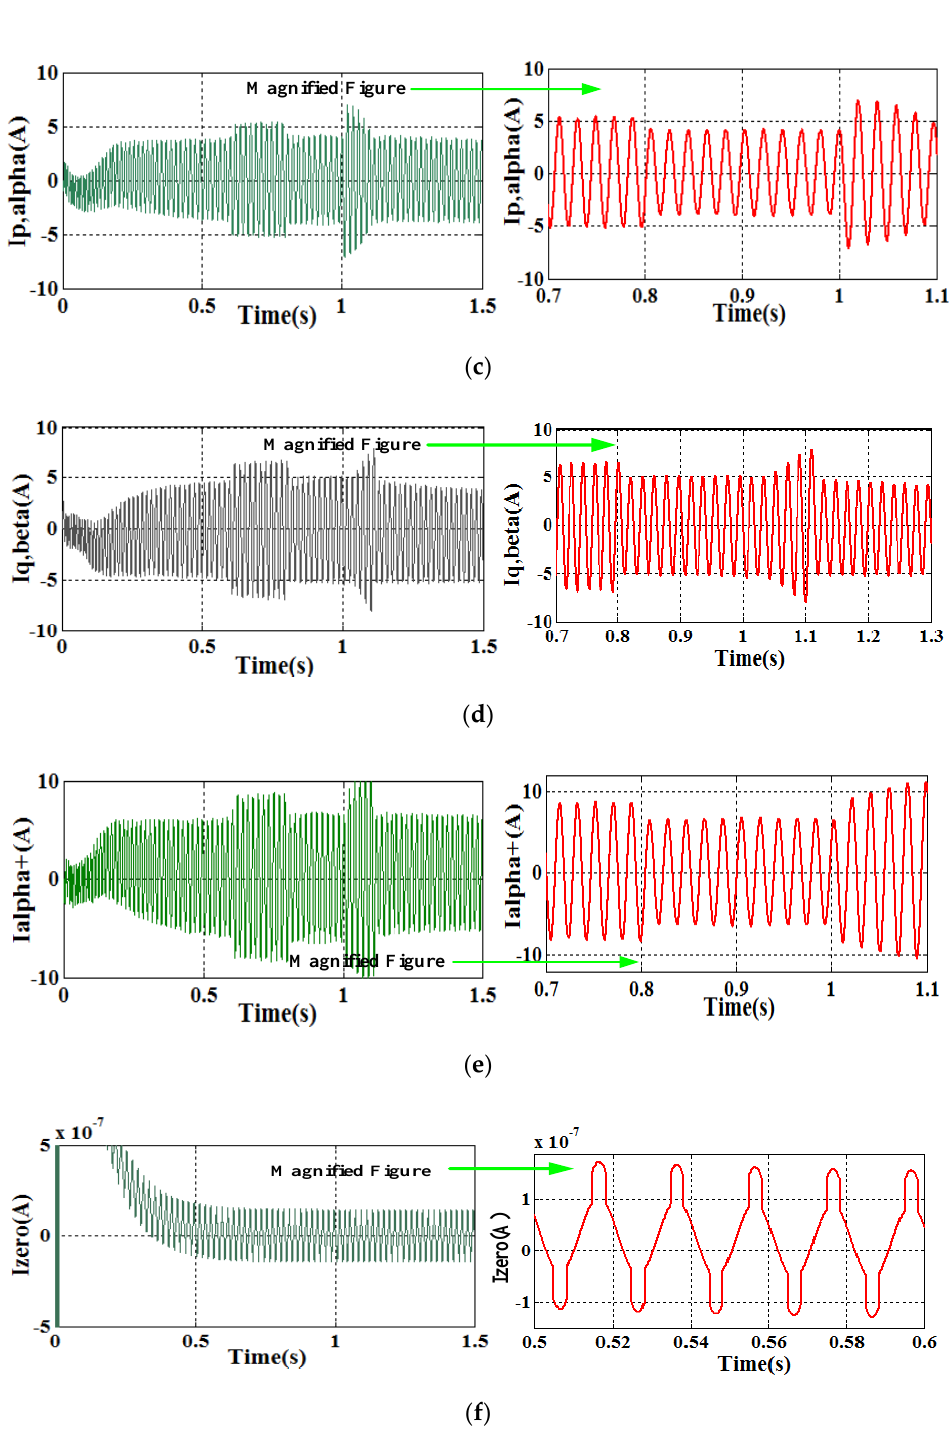
Figure 6. ( a , b ) Non-linear load 𝛼𝛽 current component, ( c , d ) active and reactive power components, ( e ) linear reference active current component produced by combining all grid and load data, and ( f ) neutral current component.